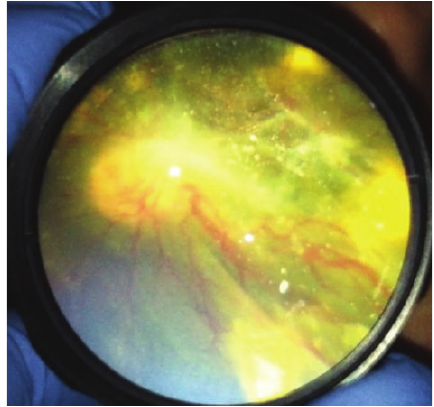
Figure 4: Familial exudative vitreoretinopathy imaged during examination under anesthesia.